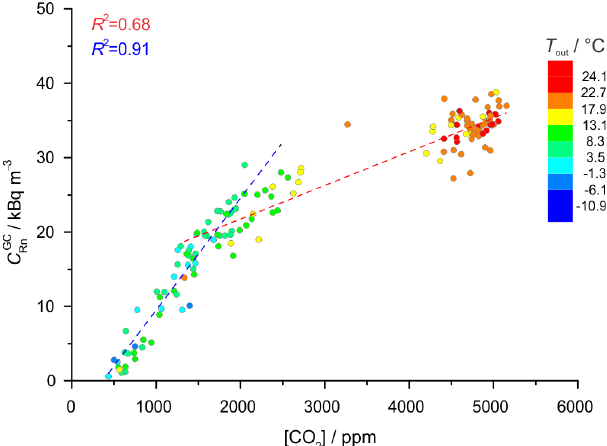
Fig. 4. Correlation between daily mean values of radon concentra- ) and CO 2 concentration at GC location depending on tion ( C GC Rn outside air temperature (colour